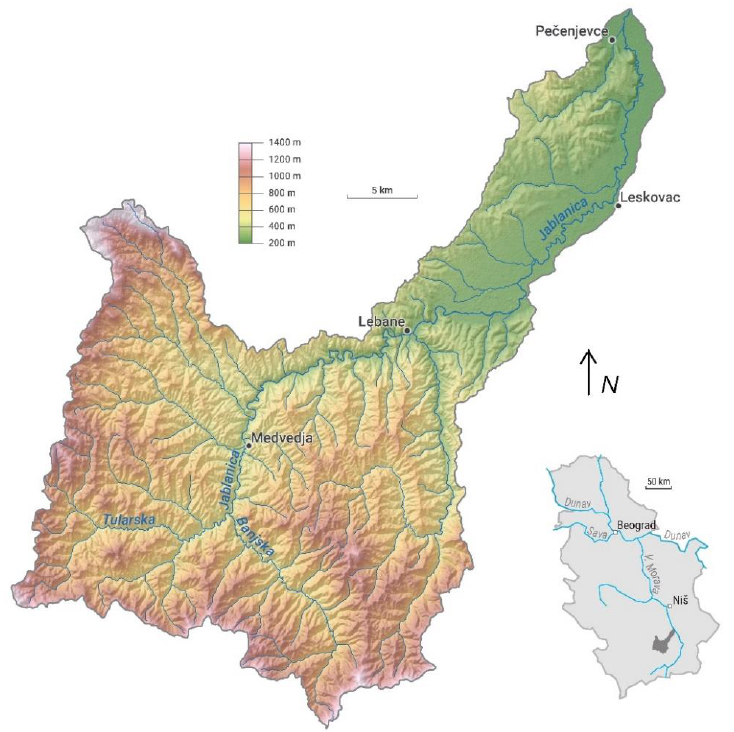
Figure 1. Geographical position of the Jablanica River Basin in the Republic of Serbia.